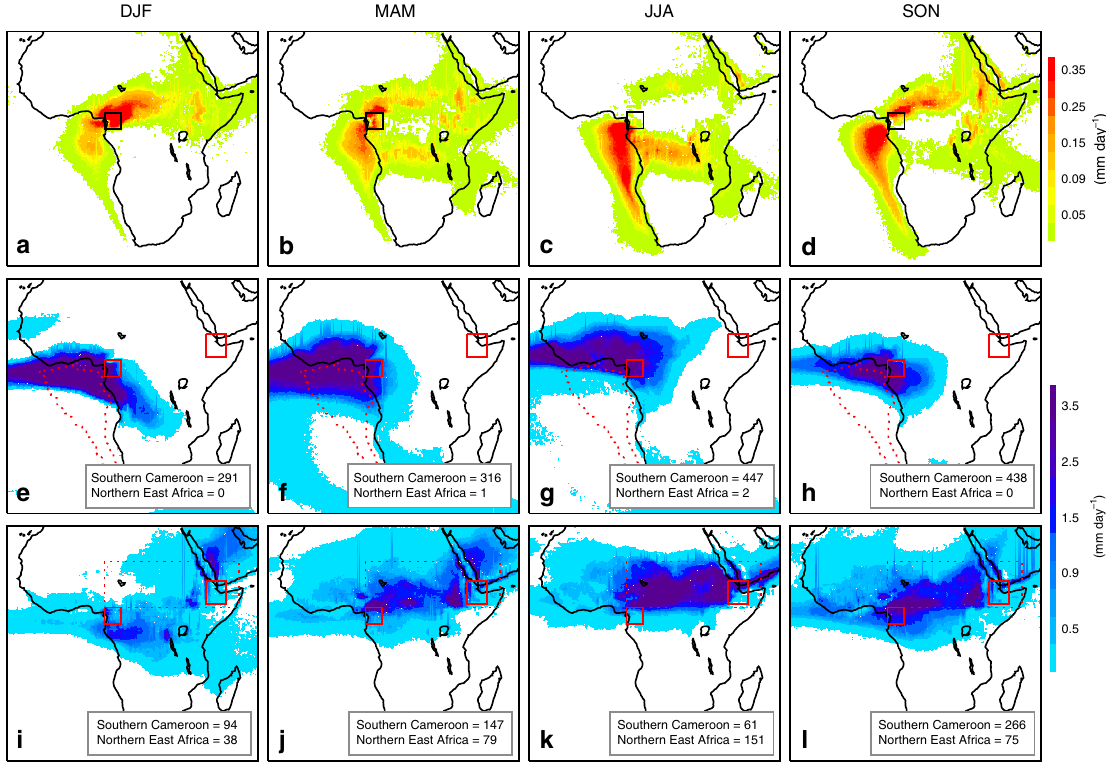
Fig. 2 Moisture sources for southern Cameroon and northern East Africa. a – d FLEXPART 84, 85 backward analyses of air mass trajectory for the period 1980 – 2015 at 0.25° resolution. The boxed region in southern Cameroon (9° E-14° E and 1° N-6° N) represents the estimated leaf-wax source region for Gulf of Guinea core GeoB4905-4. Colours represent the sources of moisture for the boxed region and show where E-P > 0 (mm day − 1 ). e – h Forward runs of FLEXPART for the southeast Atlantic moisture source (outlined with a red dashed line). Colours show precipitation derived from this moisture source (mm day − 1 ). Numbers indicate total seasonal precipitation amount (mm) from this moisture-source delivered to the boxed regions in southern Cameroon and northern East Africa. The boxed region in northern East Africa represents the leaf-wax source region for the Gulf of Aden core P178-15P, estimated as 40° E-46° E and 7° N-14° N. i – l As e – h but for the Sahel-Sahara moisture source (9° E – 50° E and 6° N – 20° N; marked with a red dashed rectangle). a , e , i represent Dec – Jan – Feb (DJF), b , f , j represent Mar – Apr – May (MAM), c , g , k represent Jun – Jul – Aug (JJA) and d , h , l represent Sep – Oct – Nov